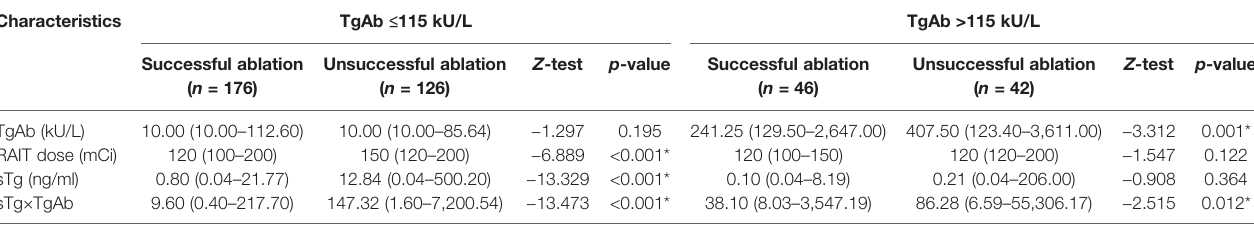
TABLE 5 | Comparison of the three independent risk factors for unsuccessful ablation of the TgAb-negative group ( ≤ 115 kU/L) and the TgAb-positive group (>115 kU/ L) on the ef fi cacy of the initial 131 I treatment.